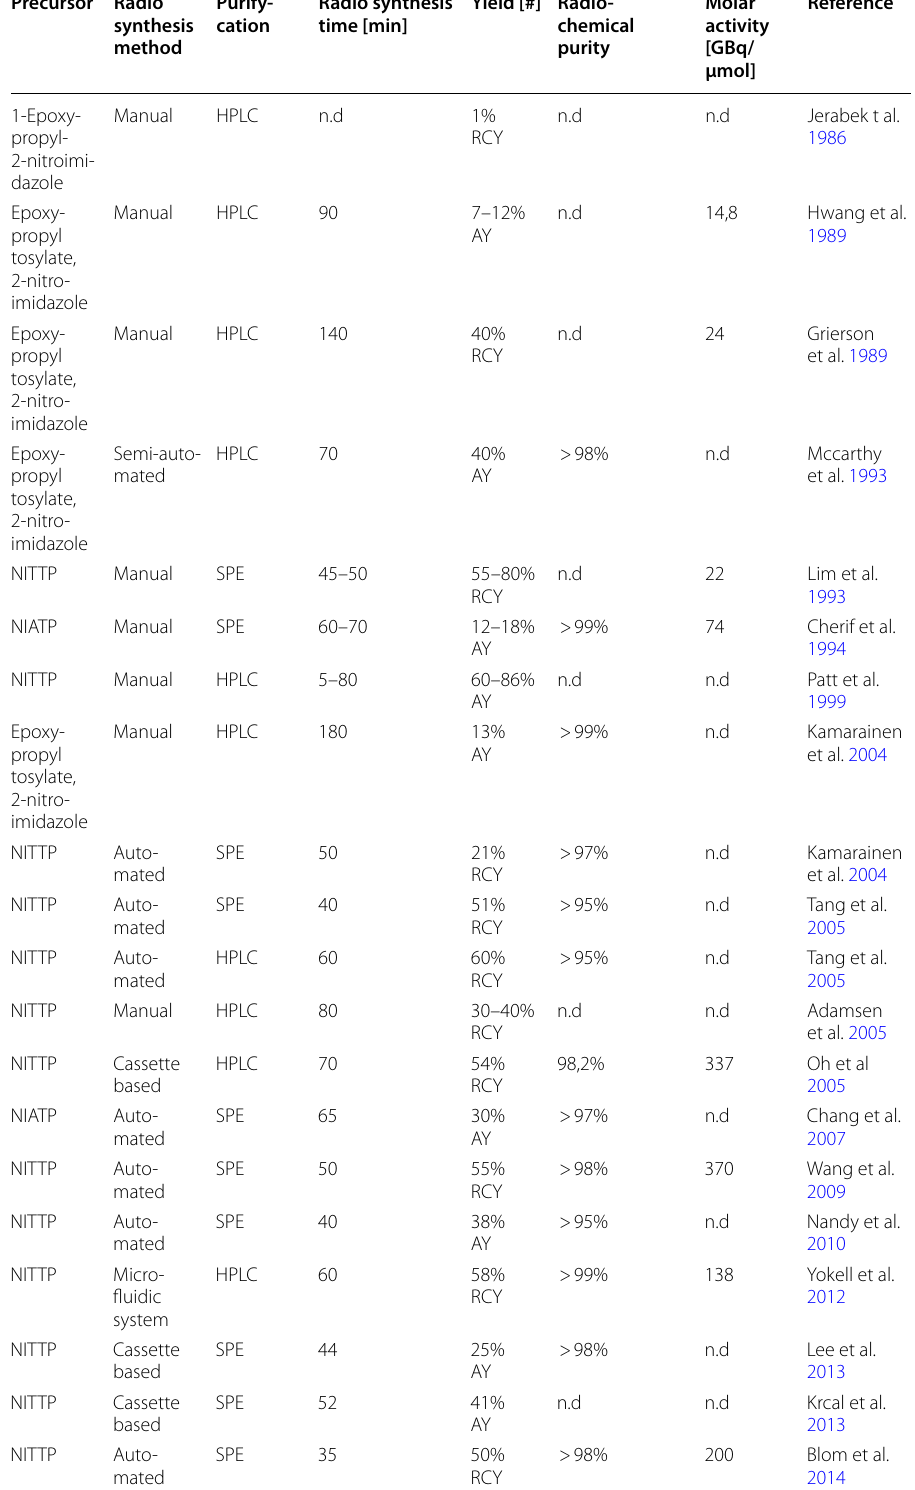
Table 1 Summary of [ 18 F]FMISO manufacturing methods, Precursor Radio